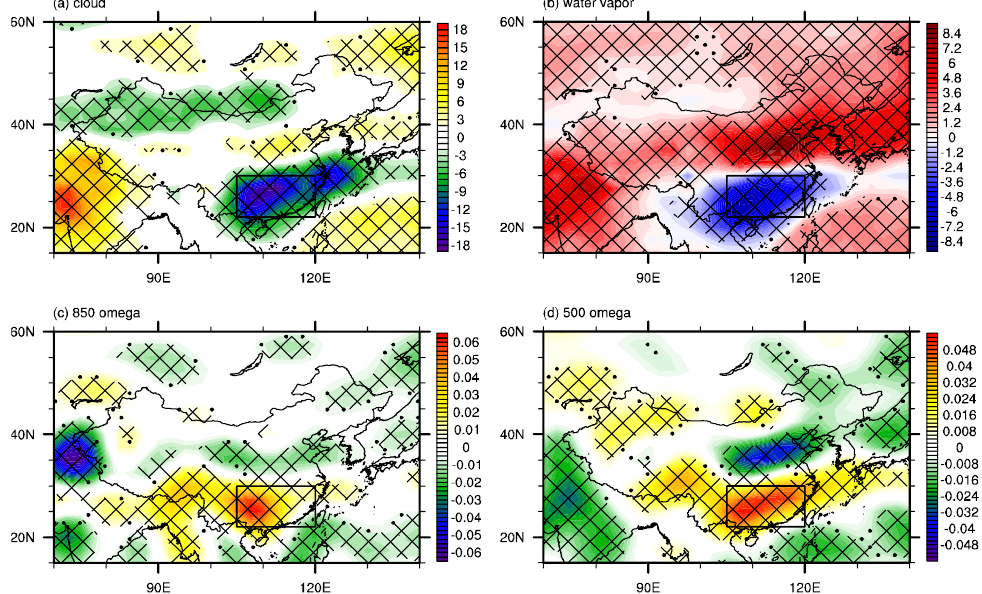
Figure 4. The composite anomalies of summer mean ( a ) total cloud amount (unit: %), ( b ) atmospheric water vapor content (unit: kg m − 2 ), (c) 850–hPa vertical velocity (unit: 10 − 3 Pa s − 1 ), and (d) 500–hPa vertical velocity (unit: 10 − 3 Pa s − 1 ) based on the 267 regional EHEs over southern China. Dots and meshes in ( a – d ) denote where the anomalies are significant at the 90% and 95% confidence levels based on Student’s t -test, respectively. The black rectangle in ( a – d ) refers to the domain of southern China.